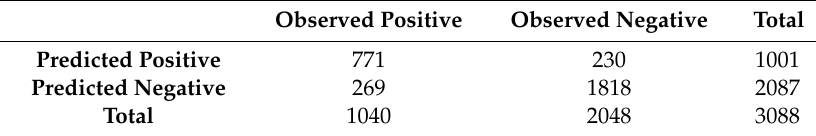
Table 3. Classification matrix of the 3088 pixels used to test the model (epidemic 2019).